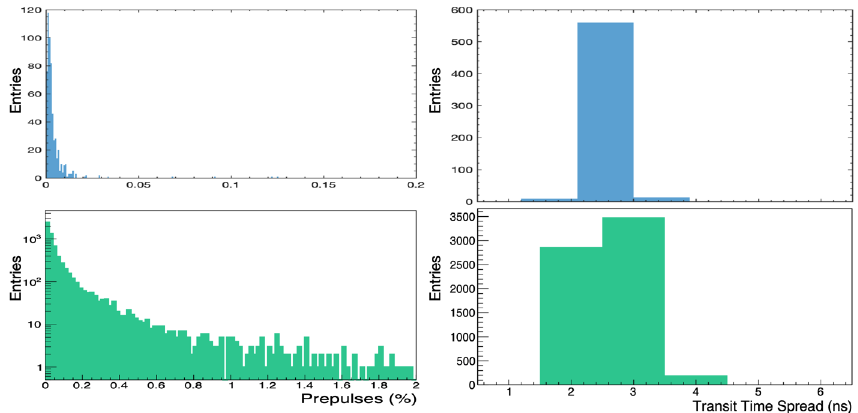
Figure 1: The dark box apparatus and two trays of R14374 PMTs ready for test